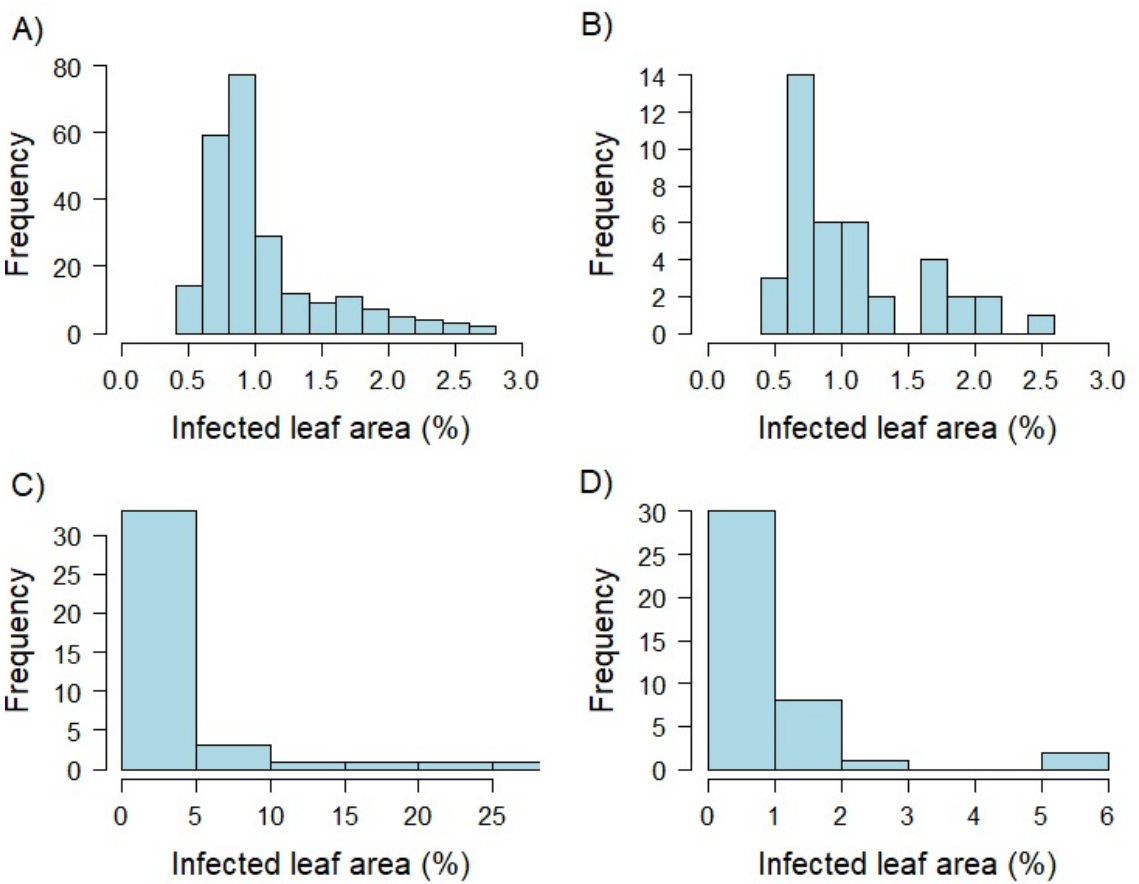
Figure 1. Histograms showing the distribution of best linear unbiased estimates (BLUEs) based on detached leaf assays produced within greenhouse experiments. Percentage of infected leaf area was determined by an automated phenotyping platform using image analysis. The whole genotype set was examined as two leaf seedlings (EC 12; A ). In addition, a limited set of 40 genotypes was tested 10 days (EC 12; B ), 5 weeks (EC 19; C ), and 10 weeks (EC 25; D ) after sowing. Table 5. Pearson correlation between seedling and adult plant resistance against leaf rust based on greenhouse and field testing, respectively. The whole genotypic set was tested as 10-day old seedlings (EC 12), while selected genotypes were examined at plant developmental stages T1 (EC 12), T2 (EC 19), and T3 (EC 25) within replicated greenhouse trials. All Genotypes at Plant Stage T1 T1 T2 T3 Pearson correlation to field data 0.40